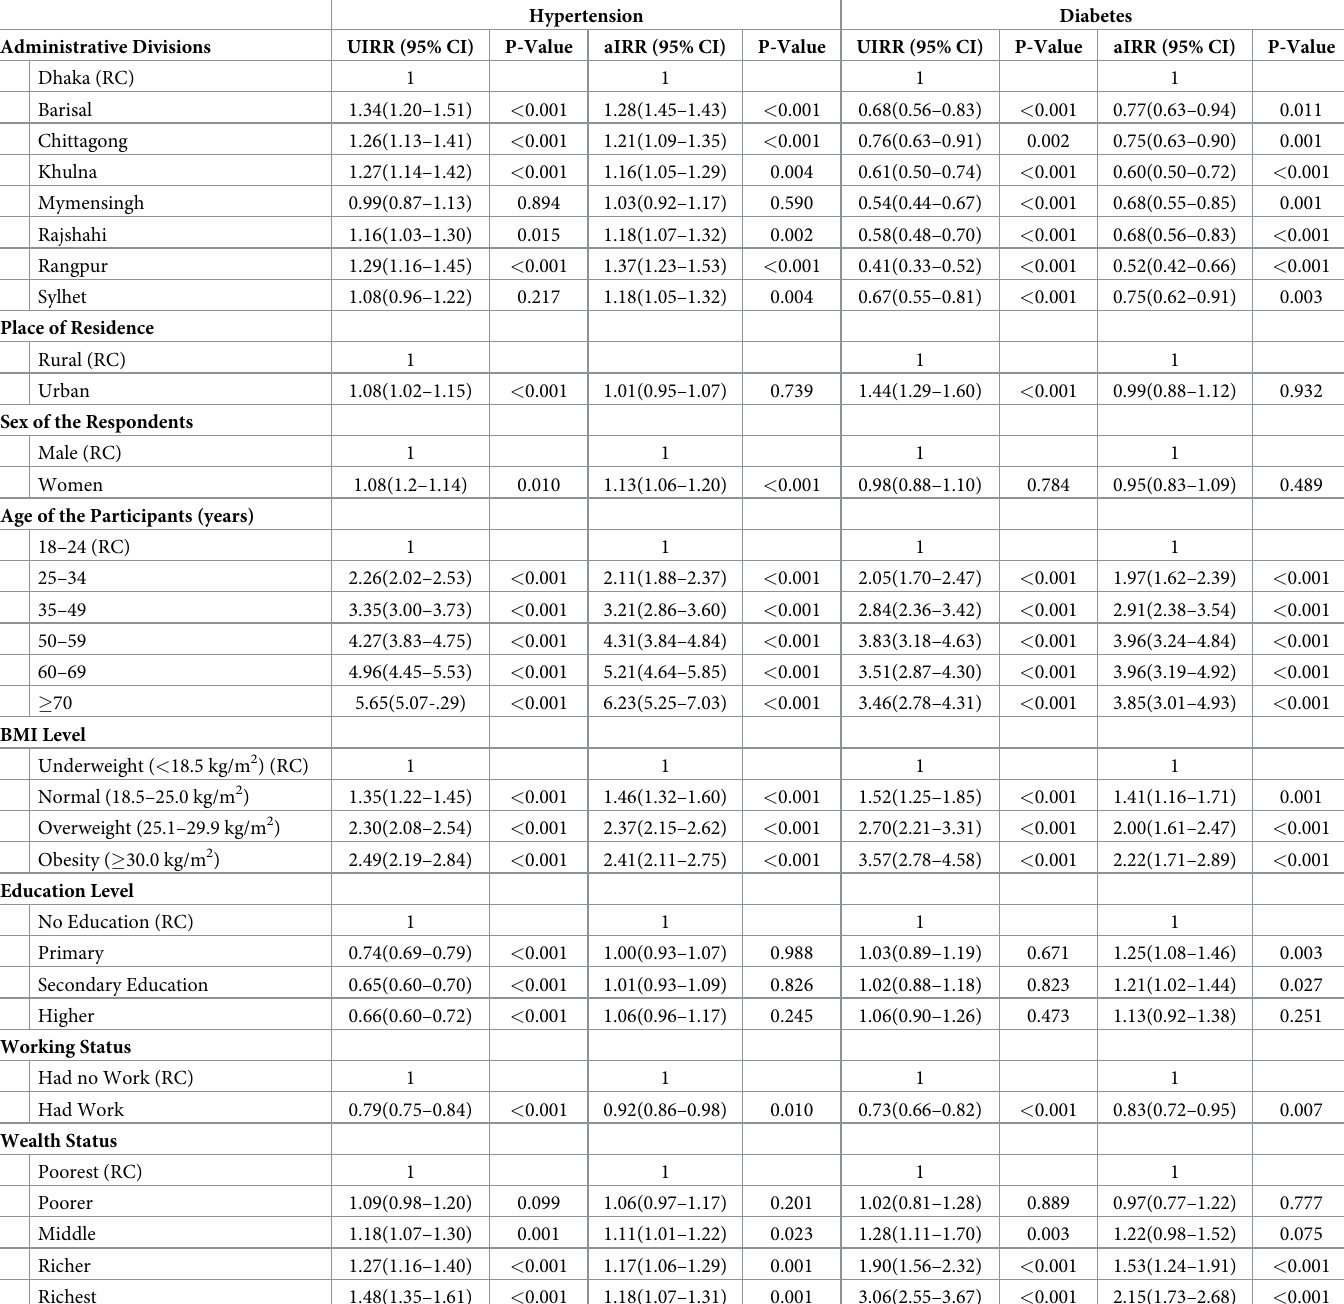
Table 3. Factors associated with hypertension and diabetes: BDHS